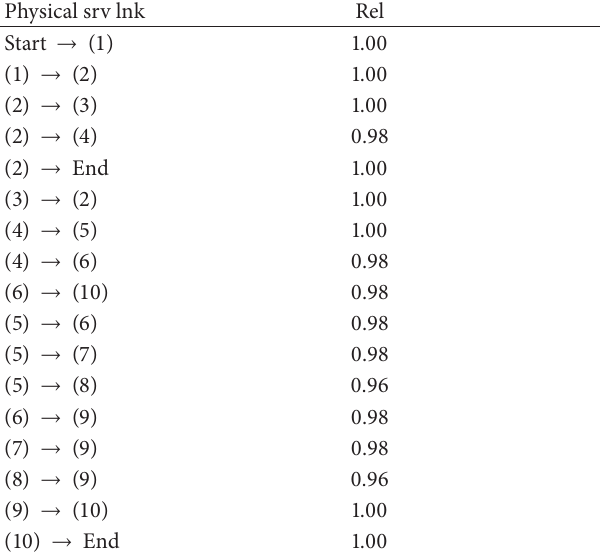
Table 3: Physical service link